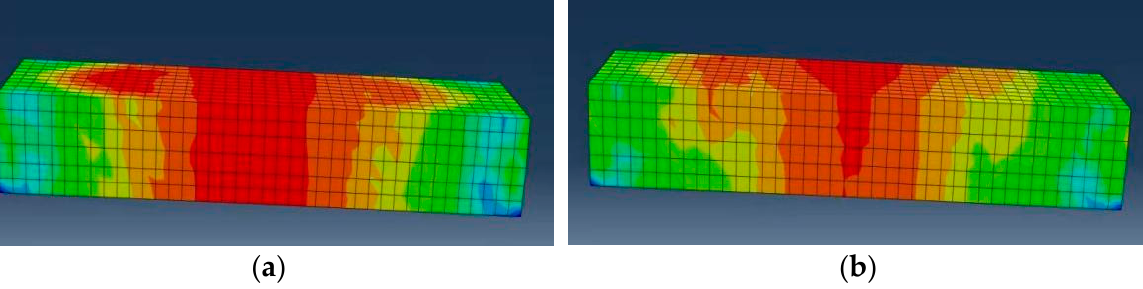
Figure 19. Vertical displacement program of reinforced components with different freeze–thaw cycles: ( a ) 100 freeze–thaw cycles; ( b ) 150 freeze–thaw cycles.